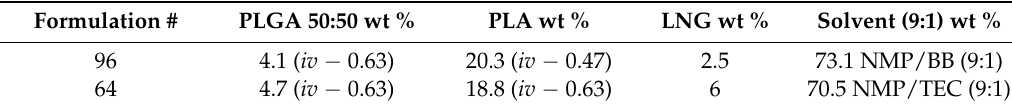
Table 1. The composition of formulations for in vitro release study.